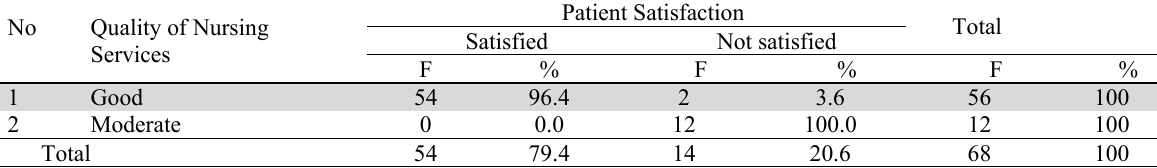
Distribution of responses to the quality of nursing services to patient